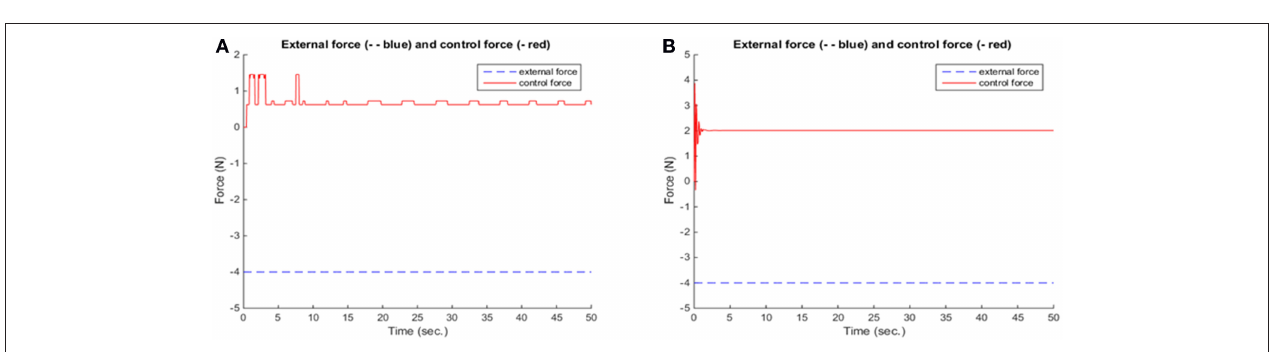
FIGURE 10 | Diagram of forces for (A) fuzzy controller and (B) neuro-fuzzy